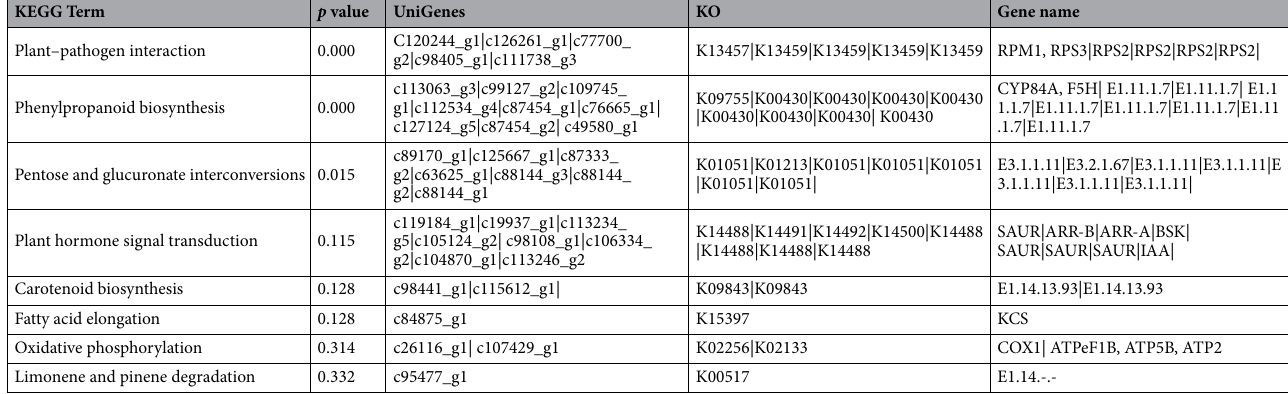
Table 2. DEGs annotated in the top 10 KEGG and top 15 GO